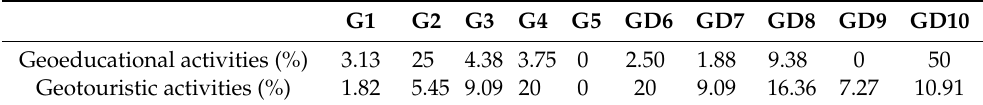
Table 3. Percentages of educational and geotouristic activities carried out at the sites considered for this study from 2011 to